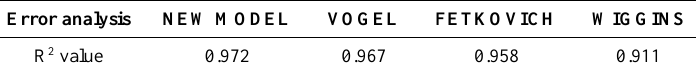
Table 3. Statistical analysis of results obtained for reservoir